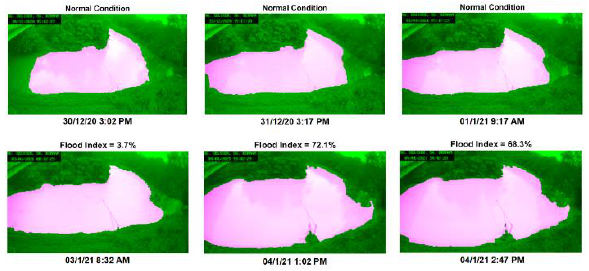
Figure 5. Flood index for all images used in this experiment.